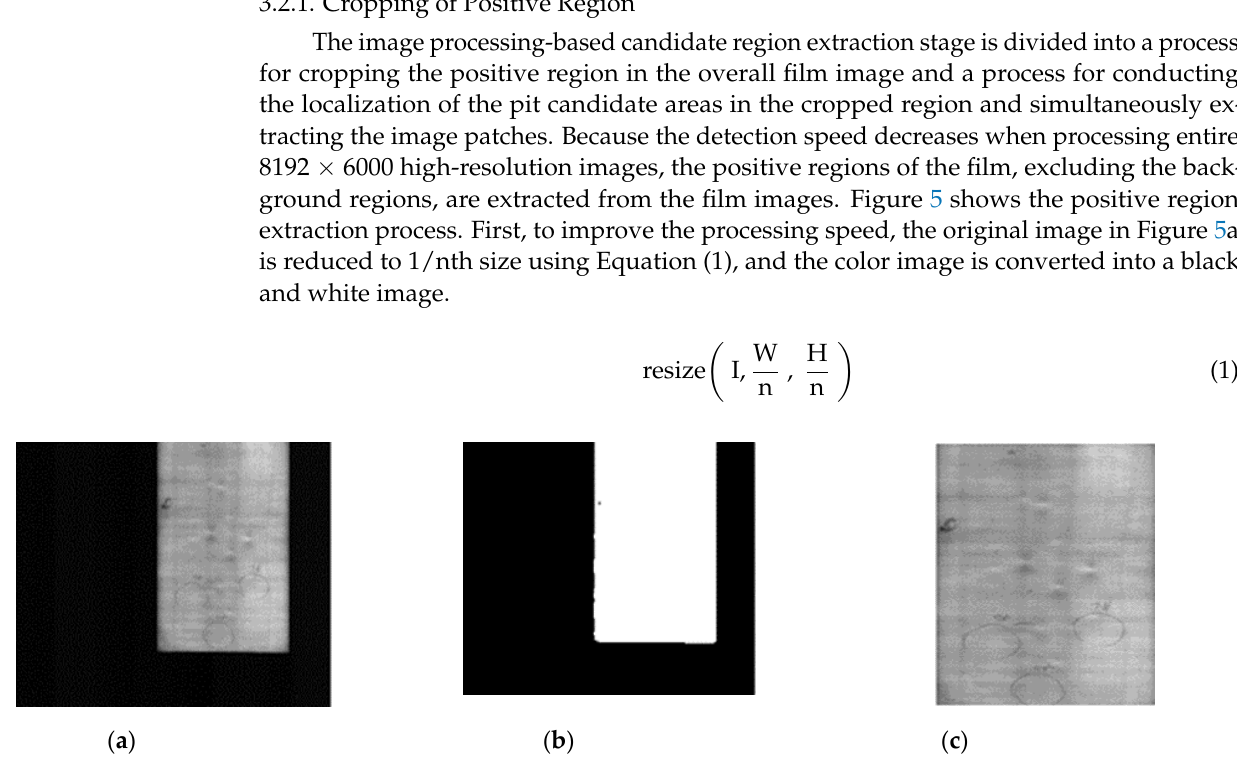
Figure 5. Positive region extraction process; ( a ) input image, ( b ) binarization result, ( c ) extracted positive region.